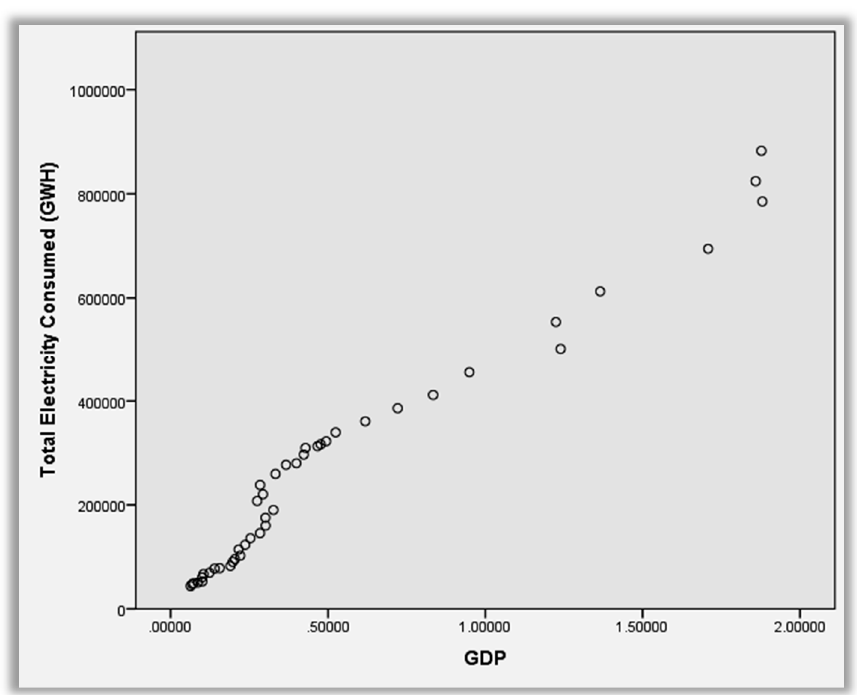
Figure 7. Plot between GDP and TEC.